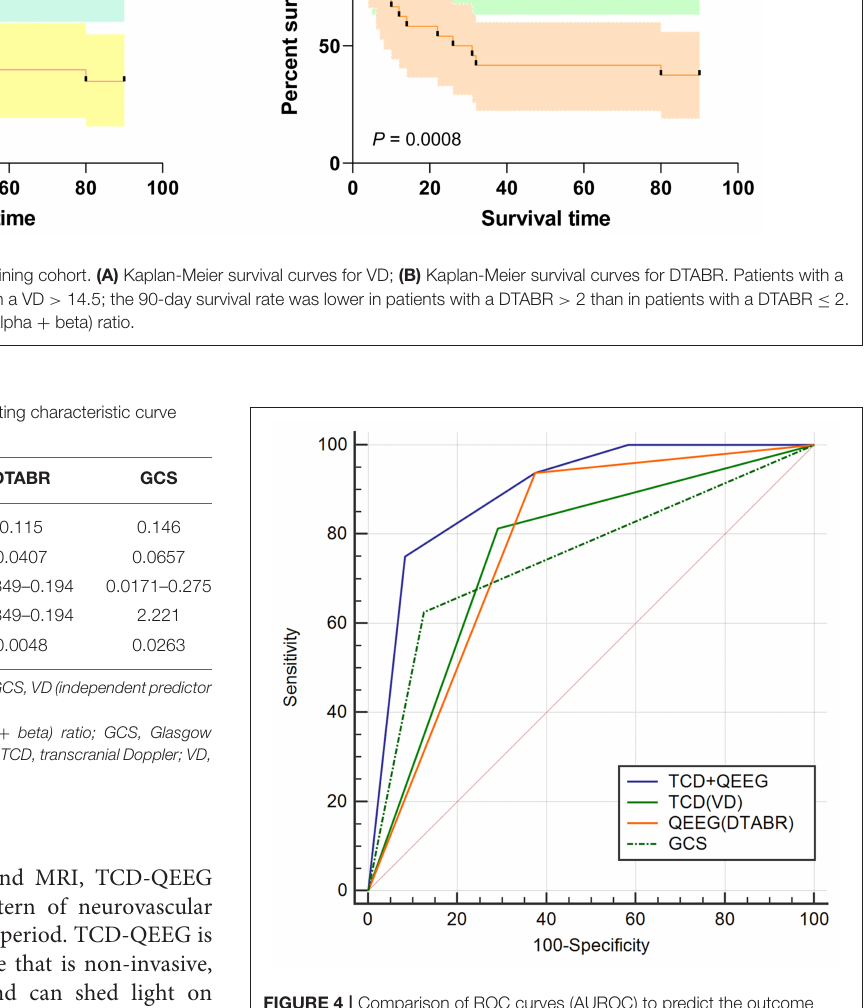
FIGURE 4 | Comparison of ROC curves (AUROC) to predict the outcome between the four models in this cohort. Glasgow Coma Scale (GCS), AUROC 0.75 (0.588–0.873); diastolic flow velocity (VD), AUROC 0.76 (0.599–0.881); (delta + theta)/(alpha + beta) ratio (DTABR), AUROC 0.781 (0.622–0.896); transcranial Doppler (TCD) + quantitative EEG (QEEG), AUROC 0.896 (0.758–0.97). P < 0.05 for TCD (VD) + QEEG (DTABR) comparison with GCS, VD (independent predictor of TCD), and DTABR (independent predictor of